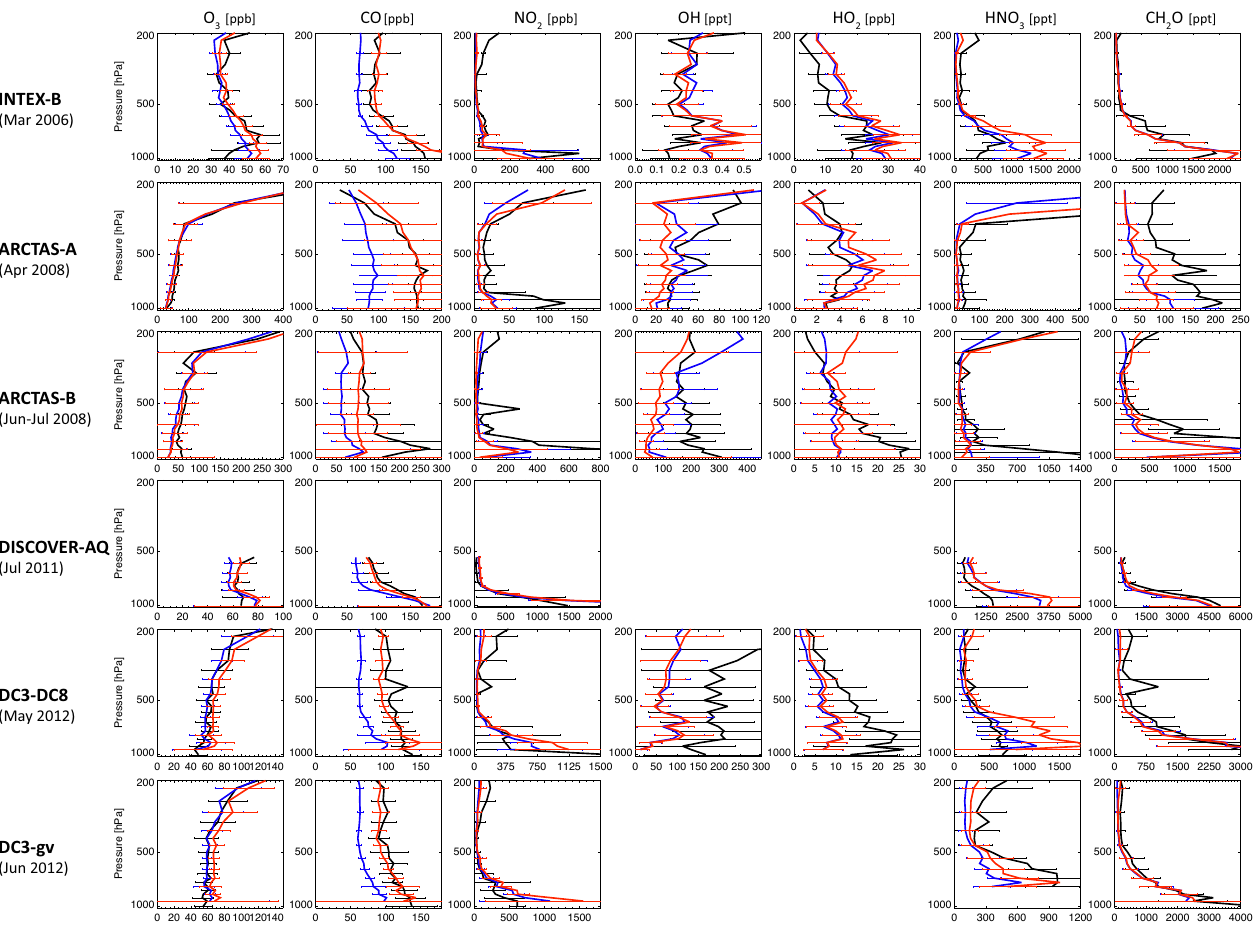
Figure 10. Mean vertical profiles of O 3 (ppb), CO (ppb), NO 2 (ppb), OH (ppt), HO 2 (ppb), HNO 3 (ppt), and CH 2 O (ppt) obtained from aircraft measurements (black), control run (blue), and reanalysis (red), for the INTEX-B profile (first row), ARCTAS-A profile (second row), ARCTAS-B profile (third row), DISCOVER-AQ profile (fourth row), DC3-DC8 profile (fifth row), and DC3-GV profile (sixth row). Error bars represent the standard deviation of all data within one bin (with an interval of